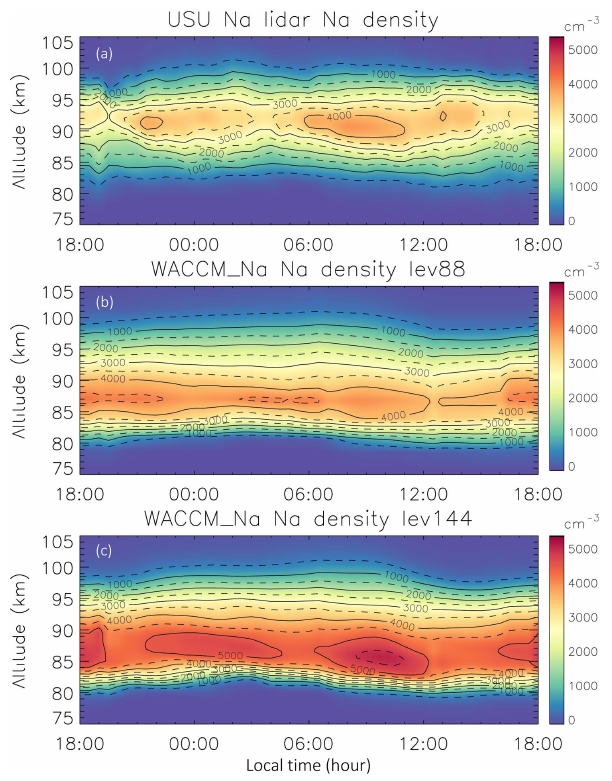
Figure 2. The averaged lidar measured Na density variation during the 7-day Na lidar campaign between 27 September and 3 Octo- ber 2012 (a) ; the Na density variations at USU locations during the same time frame, simulated by WACCM_Na 88-level (b) and 144- level (c) .